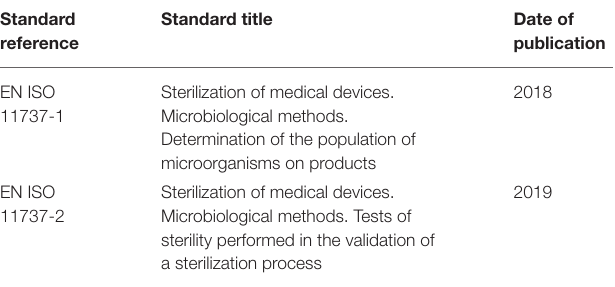
TABLE 6 | Standards for microbiological methods to support microbiological